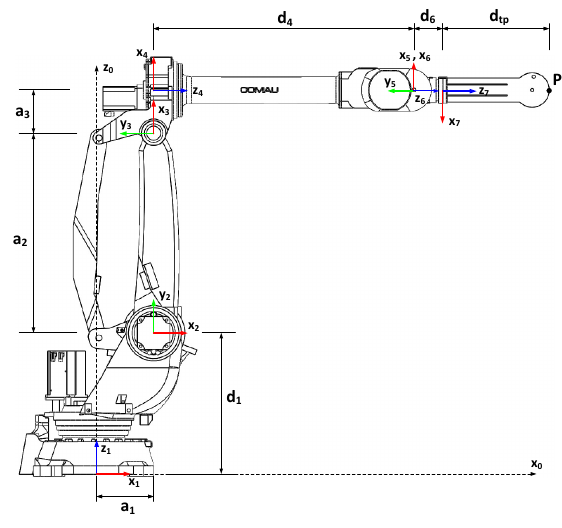
Figure 12: Geometric overview of the Comau Smart-5